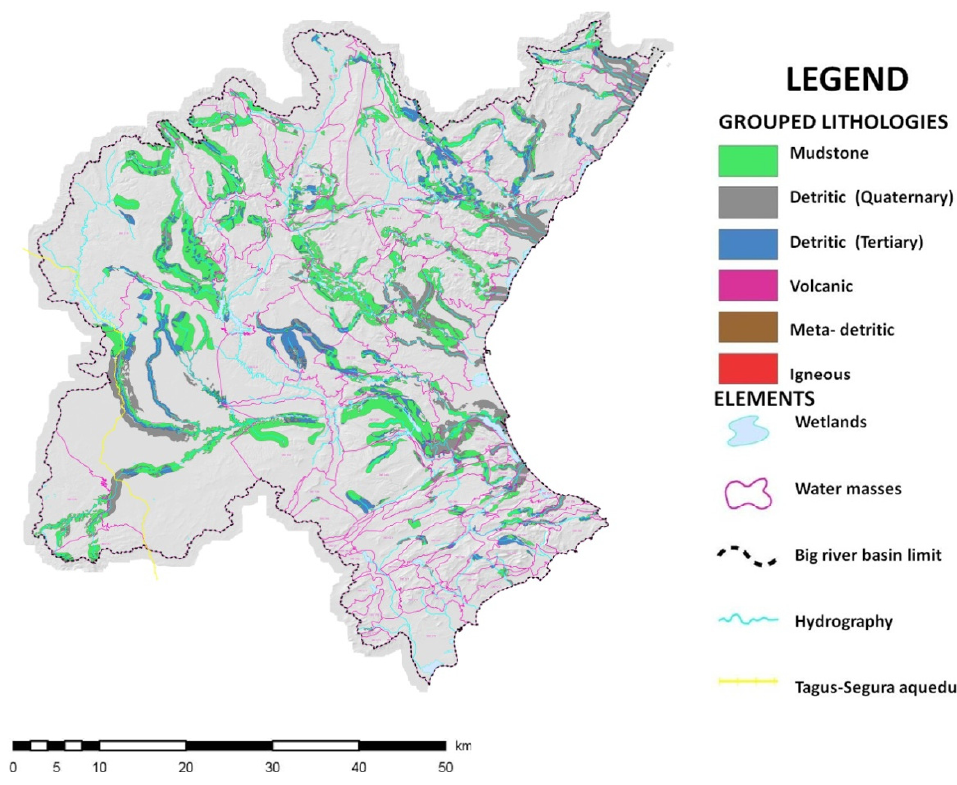
Figure 2. Example of the distribution of “MAR zones” in the Spanish Jucar